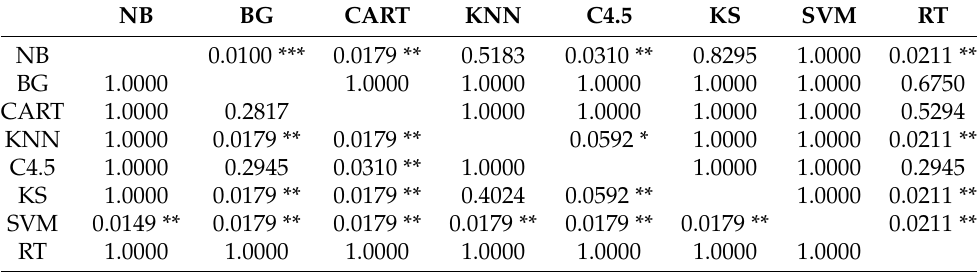
Table 13. Pairwise WSR test for accuracy of child.